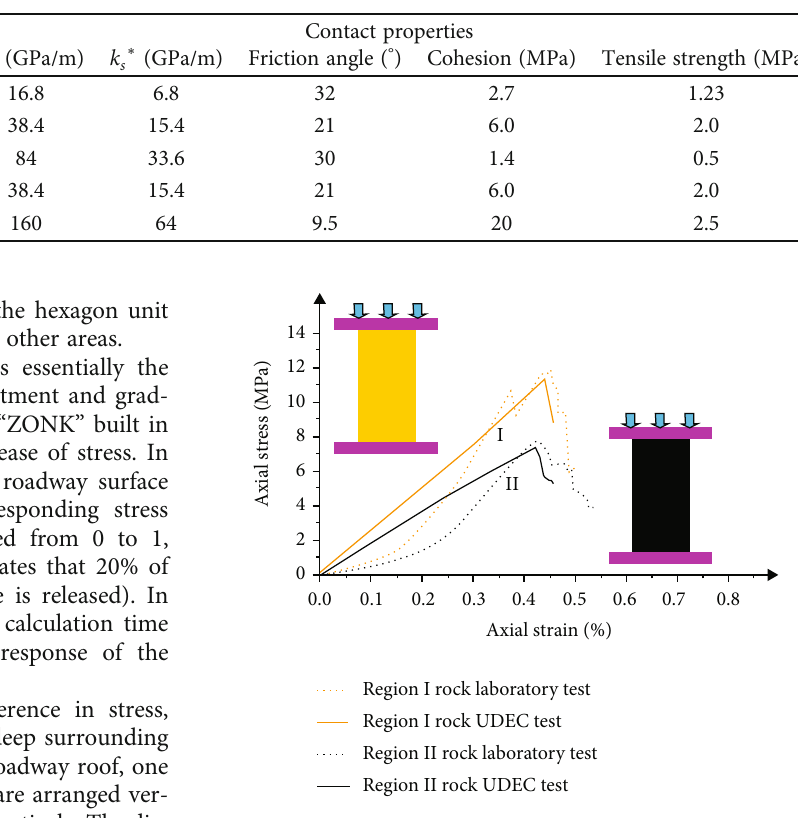
Figure 7: Geometry and boundary conditions of numerical computation model. Table 1: Physical and mechanics parameters for the simulated model.